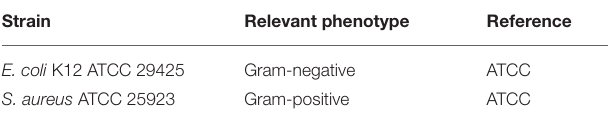
TABLE 1 | Different strains used in the present